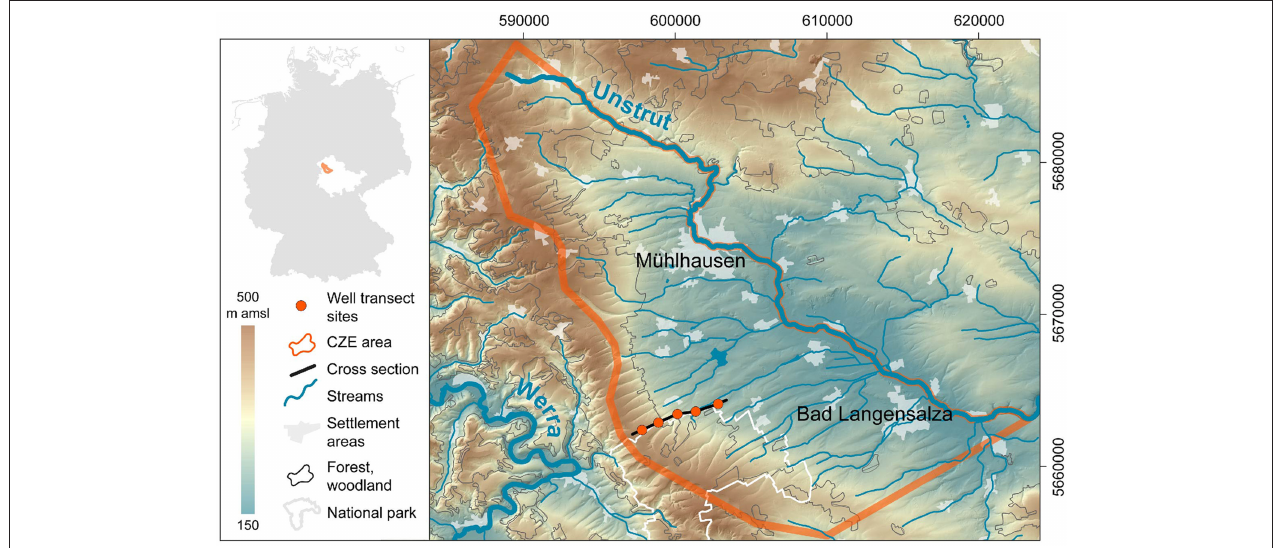
FIGURE 3 | Location of the Hainich CZE in a topographic map of northwestern Thuringia/Germany. Data Sources: DEM © GeoBasisDE/TLVermGeo, Gen.-Nr.:12/2015; DLM250 (c) GeoBasis-DE/BKG 2014: Coordinate system ETRS89/UTM, zone